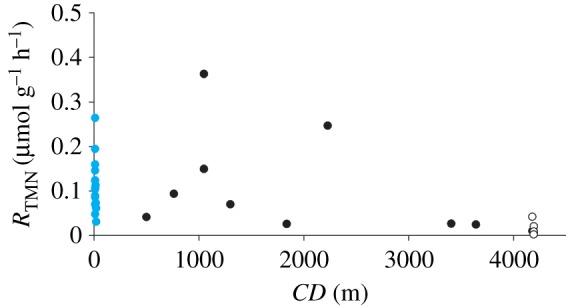
Temperature- and mass-normalized holothurian metabolic rate (RTMN) over collection depth (CD). Metabolic rate data were normalized to a temperature of 2.5°C using a shallow-water-holothurian-derived Q10 of 2.12, and to a standard total wet mass (M) of 70 g using a shallow-water-holothurian-derived mass-scaling coefficient of 0.5858. Blue circles represent shallow-water data (from [13,28–41]), black circles represent deep-sea data (from [10,13,56–59]) and open circles represent data from this study.